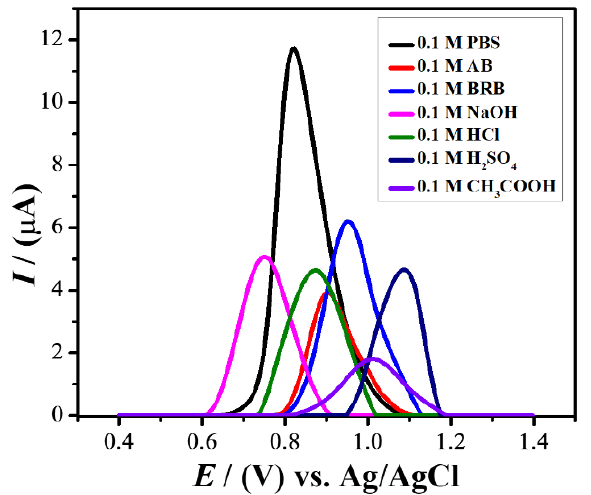
Figure 3. Anodic peak current response of 10 μM NBS in various supporting electrolytes using COOH- fMWCNTs modified GCE.